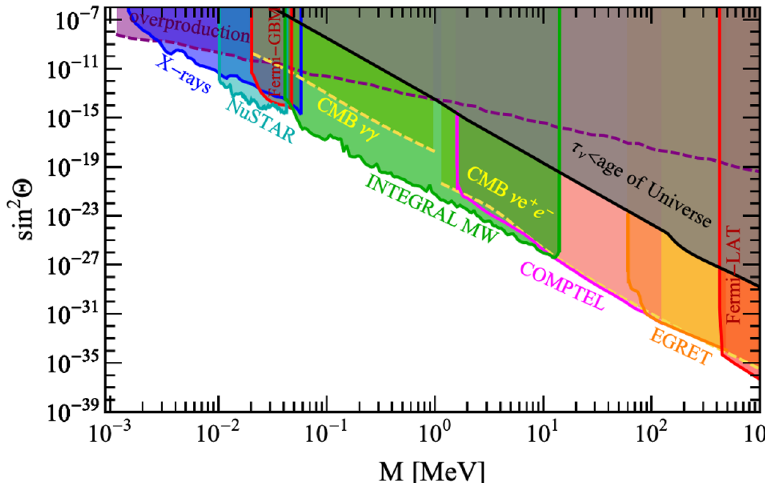
Figure 1 . Neutrino dark matter constraints on the active-sterile mixing angle (cid:2). The shaded areas are excluded by: X-ray data (dark blue), NuSTAR (dark cyan), Fermi-GBM (red), INTEGRAL (green), COMPTEL (magenta), EGRET (orange), Fermi-LAT (red). In the dark grey region, the sterile neutrino lifetime is shorter than the age of the Universe. Above the purple dashed line the sterile neutrino is overabundant (assuming production only via mixing with active neutrinos). The CMB constraints are given by the yellow dashed